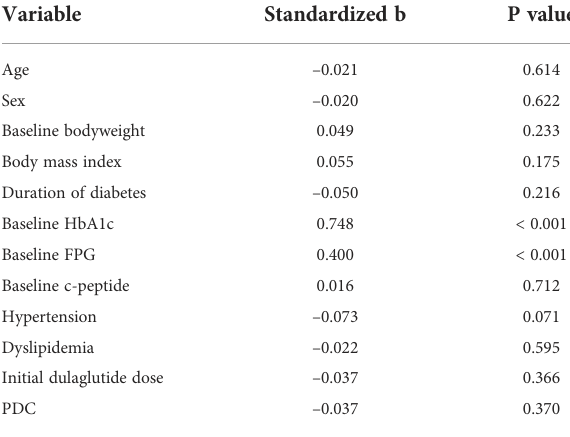
TABLE 4 Univariate linear regression analysis of HbA1c reduction after dulaglutide use.